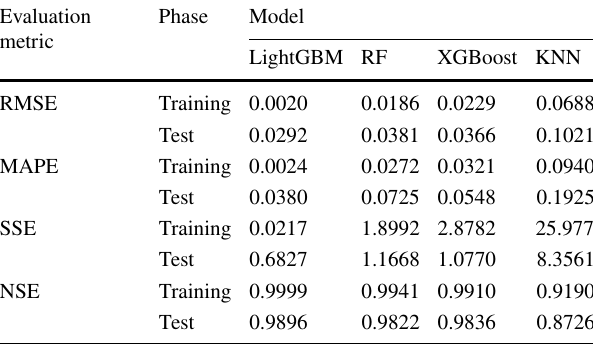
RMSE Root mean square error, MAPE Mean absolute percentage ficient, LightGBM Light gradient boosting machine, RF Random for- est, XGBoost Extreme gradient boosting, KNN k-nearest